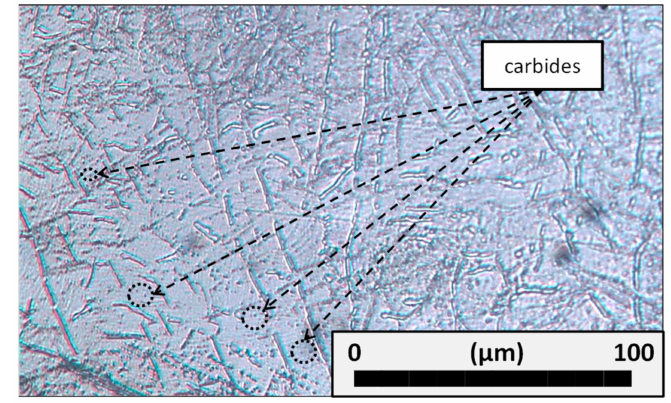
Figure 2. Microstructure of Inconel ®